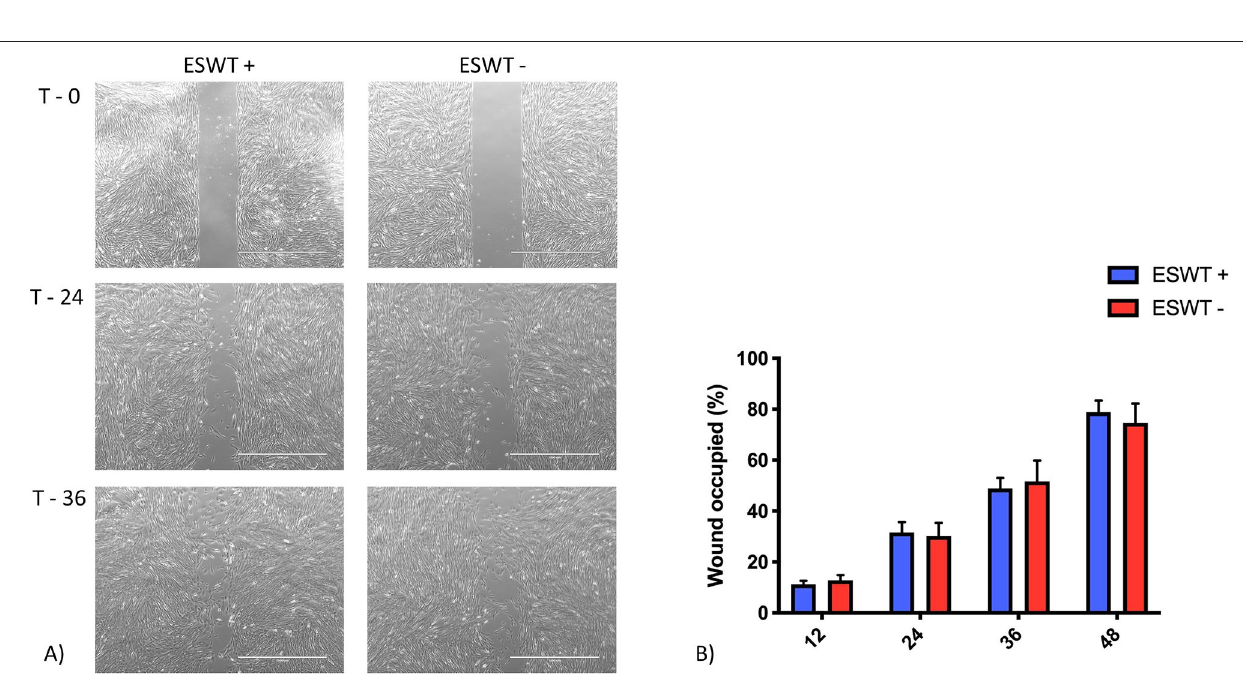
Frontiers in Veterinary Science |